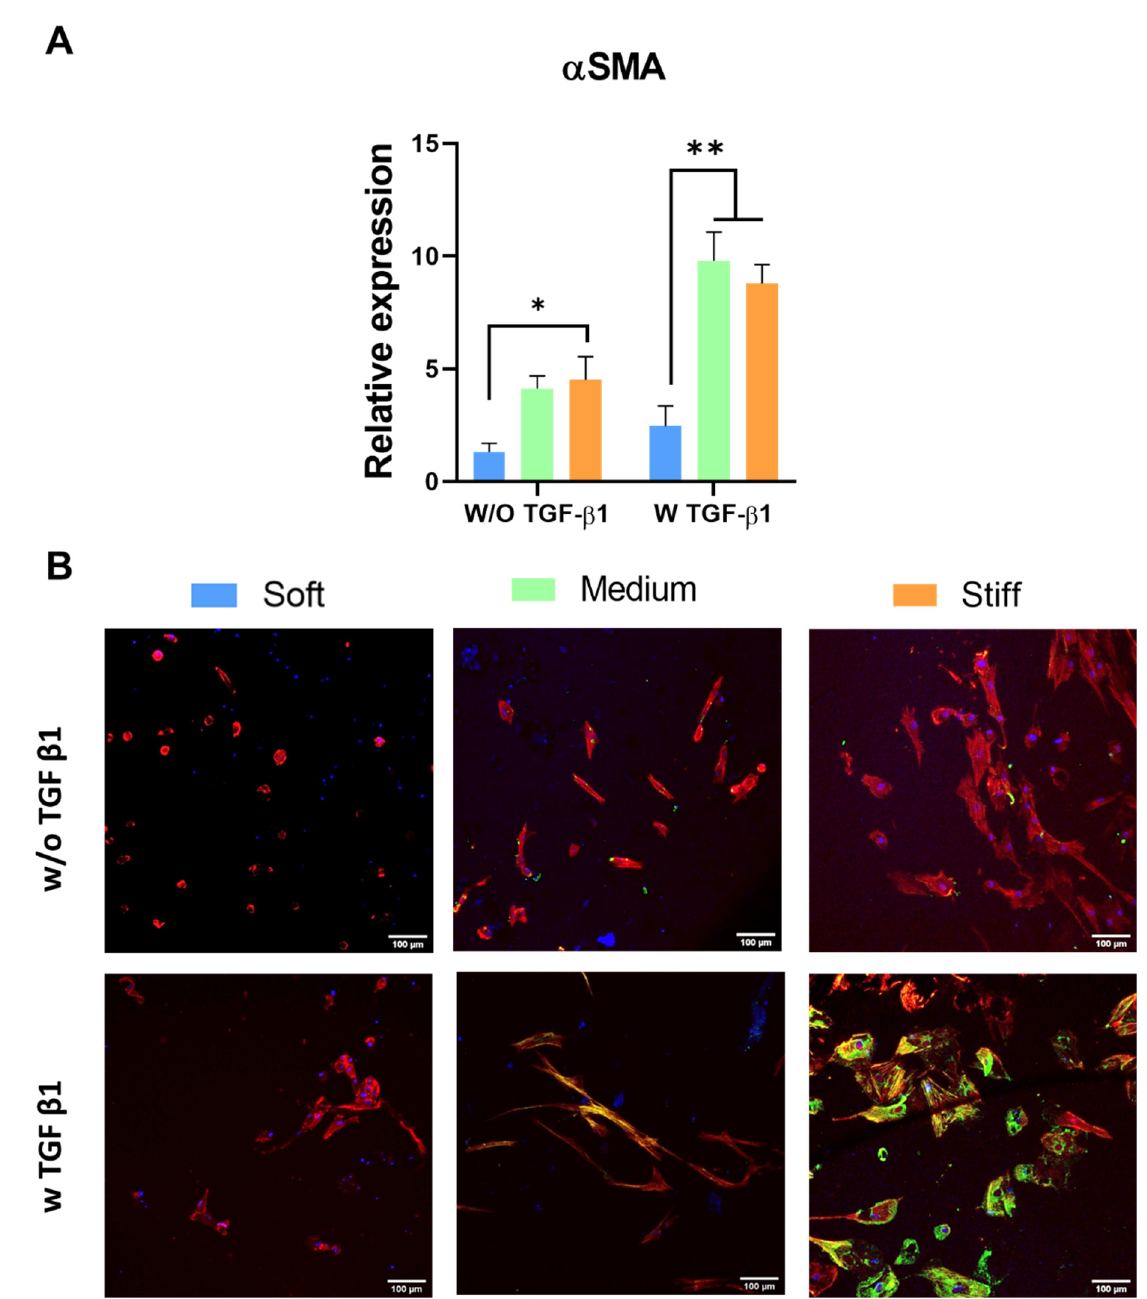
Figure 3. Effect of increasing GelMA hydrogel stiffness on α SMA gene expression (* p < 0.05 compared to the soft GelMA hydrogel in the absence of TGF- β 1; ** p < 0.05 compared to medium and stiff GelMA hydrogels in the presence of TGF- β 1) ( A ) and α SMA protein expression ( B ). The addition of TGF- β 1 enhances the production of α -SMA protein. DAPI (blue), phalloidin (red) and α SMA (green). Scale bar = 100 µm.